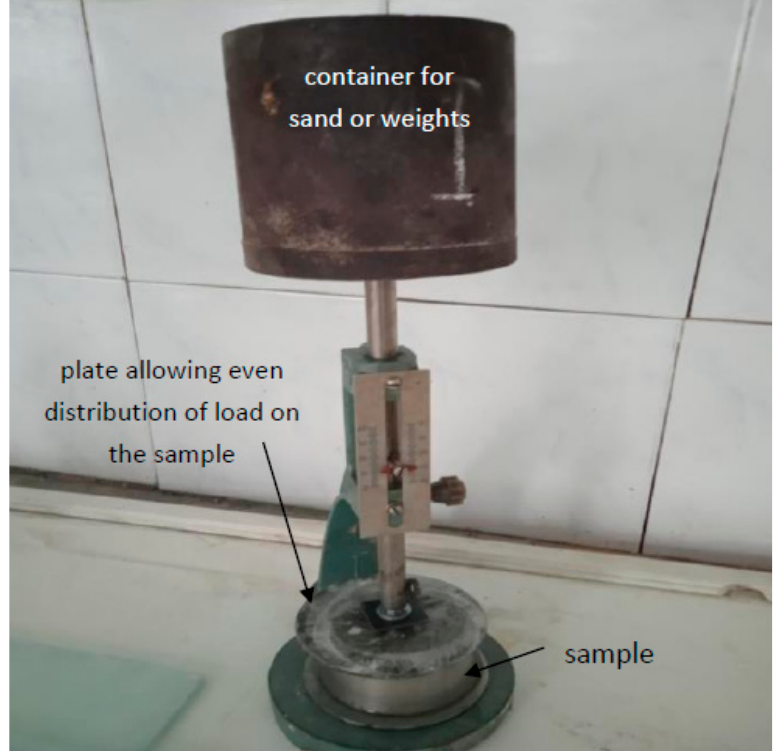
Figure 2. Device for determining the structural strength.